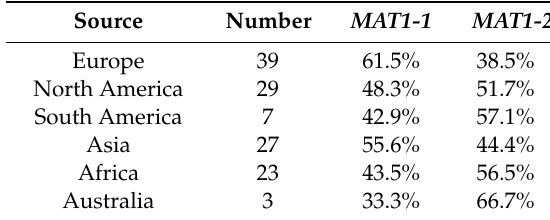
Table 1. Source and number of worldwide isolates of A. fumigatus , and distribution (%) of mating type ( MAT1-1 or MAT1-2 ) in different continents.